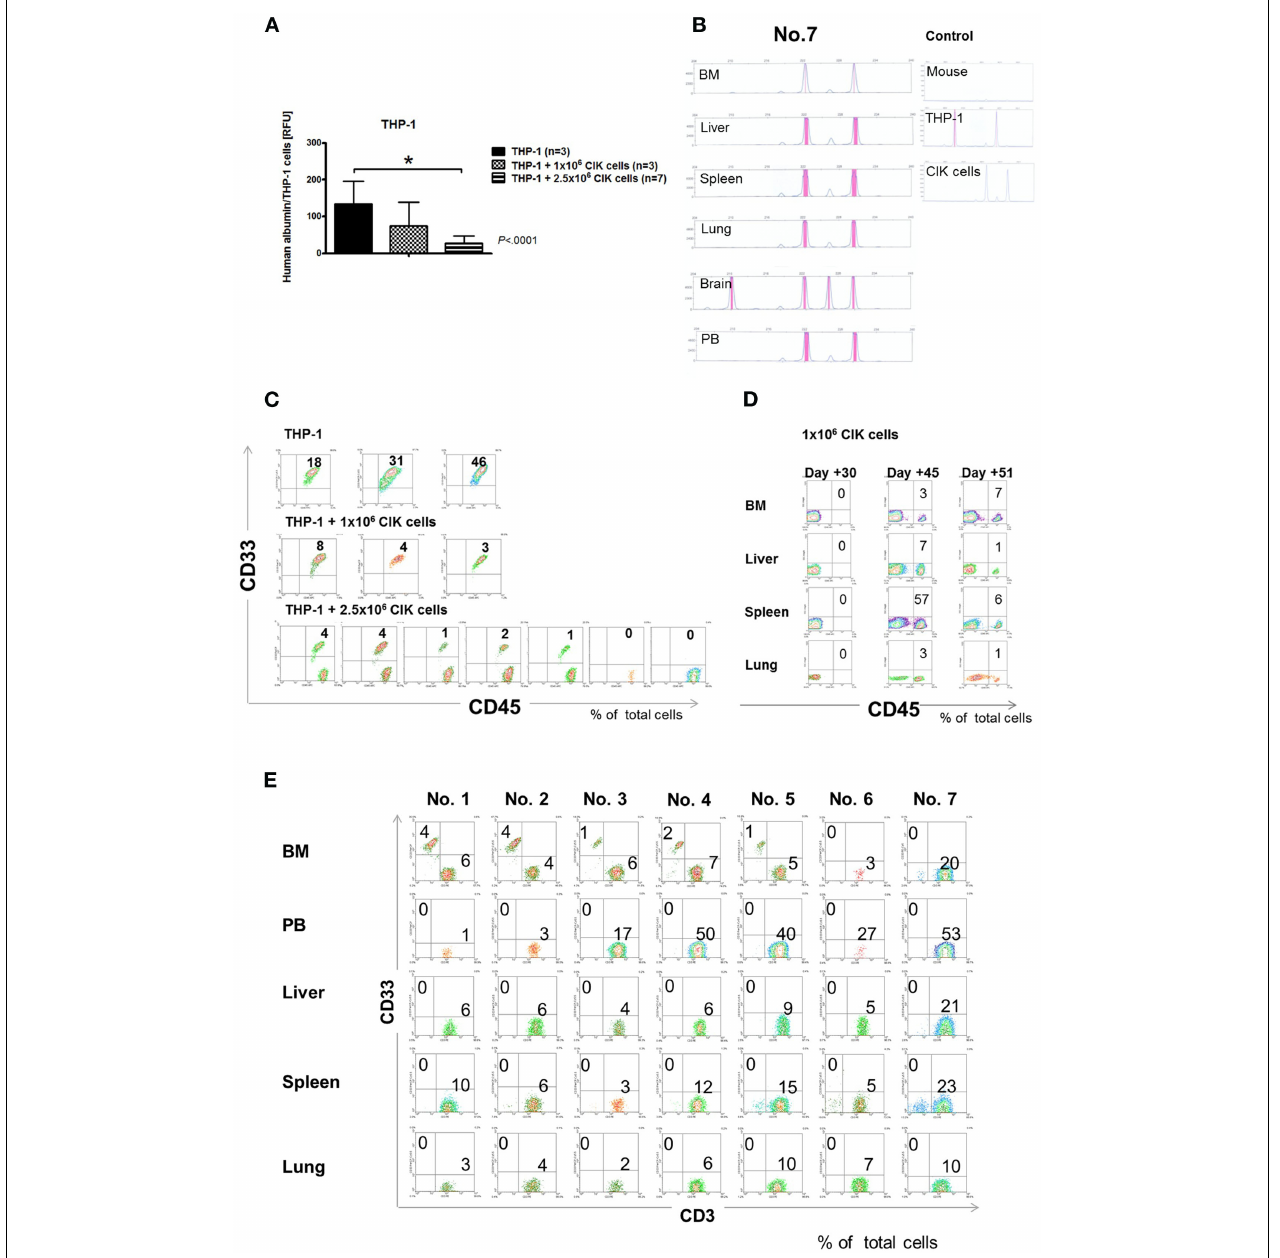
FIGURE 5 |Anti-leukemic activity of IL-15-stimulated cytokine-induced killer cells. Mice were inoculated i.v. with the minimal leukemic dose of 1 × 10 4 THP-1 cells. About 1 × 10 6 and 2.5 × 10 6 CIK cells were transplanted via the tail vein into one part of mice injected withTHP-1 cells. Bone marrow (BM), peripheral blood (PB), liver, spleen, lung, and brain were analyzed for THP-1 and CIK cell engraftment by PCR 25days after transplantation of malignant cells. Results of analyzed compartments taken together showed that CIK cell treatment resulted in a markedly decreasedTHP-1 engraftment compared with the untreated controls (A) . Reduction of leukemia burden was dose-dependent. Chimerism analysis was used to distinguish between AML and CIK cells. Chimerism results like shown here by one representative example [mouse no. 7, 1 × 10 4 THP-1 cells and 2.5 × 10 6 CIK cells, (B) ]